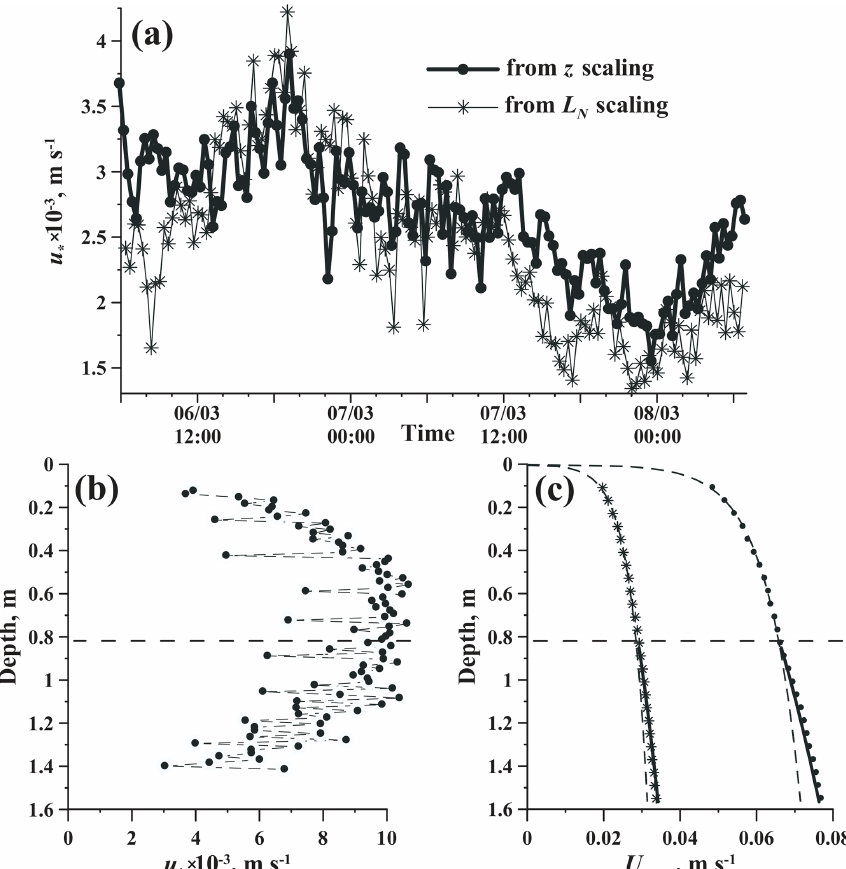
Figure 8. Ice boundary layer structure: (a) friction velocity u ∗ at station S1 as determined from the quasi-neutral production–dissipation balance (Eq. 7, thick solid line with symbols) and from the Dougherty–Ozmidov length scale (Eq. 13, thin lines) at a distance from the ice base nearly equal to the mean Ozmidov length L N ≈ 0 . 8m, (b) mean vertical profiles of u ∗ , and (c) vertical velocity profiles for strong (circles) and weak (asterisks) currents. The two profiles in (c) correspond to those in Fig. 6. Horizontal dashed line in (b, c) marks the depth equal to the mean Ozmidov length L N ≈ 0 .